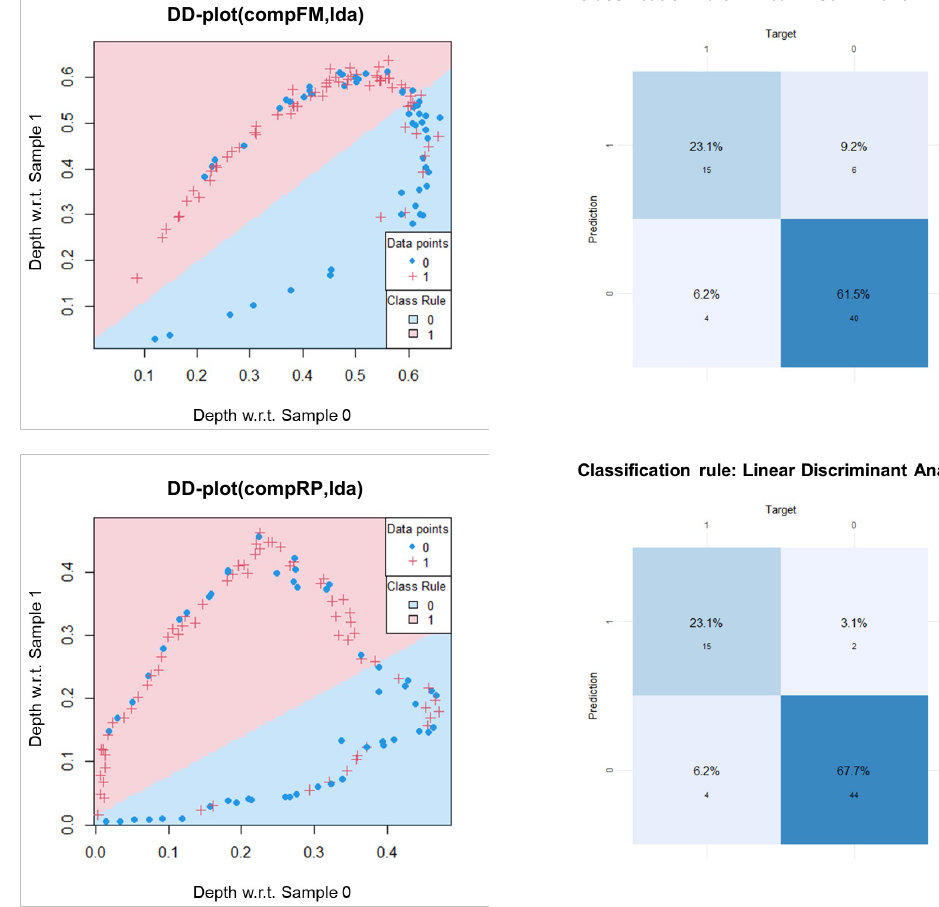
Figure 9. Results of applying the DD G -classifier to the Fourier-transformed text data i.e., together with the compositional D -depth. The DD -plot in the upper left corner uses compositional FM- depth, while the DD -plot in the lower left corner uses compositional RP-depth. In both cases, linear discriminant analysis is used as the classification rule. The top right plot shows the confusion matrix that results when the DD G -classifier (compFM,lda) is applied to the test sample. Similarly, the bottom right plot shows the confusion matrix that results when the DD G -classifier (compRP,lda) is applied to the test